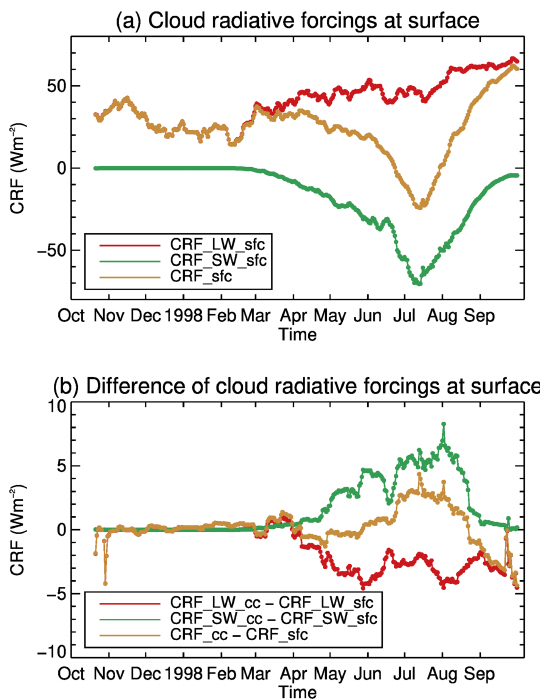
Figure 9. (a) CRF with a 20d running average of daily means at the surface for longwave (LW) and shortwave (SW) with clouds from surface observations collected during the SHEBA experiment and (b) CRF differences with clouds identified by the combined Cloud- Sat and CALIPSO (CC) and all clouds from surface